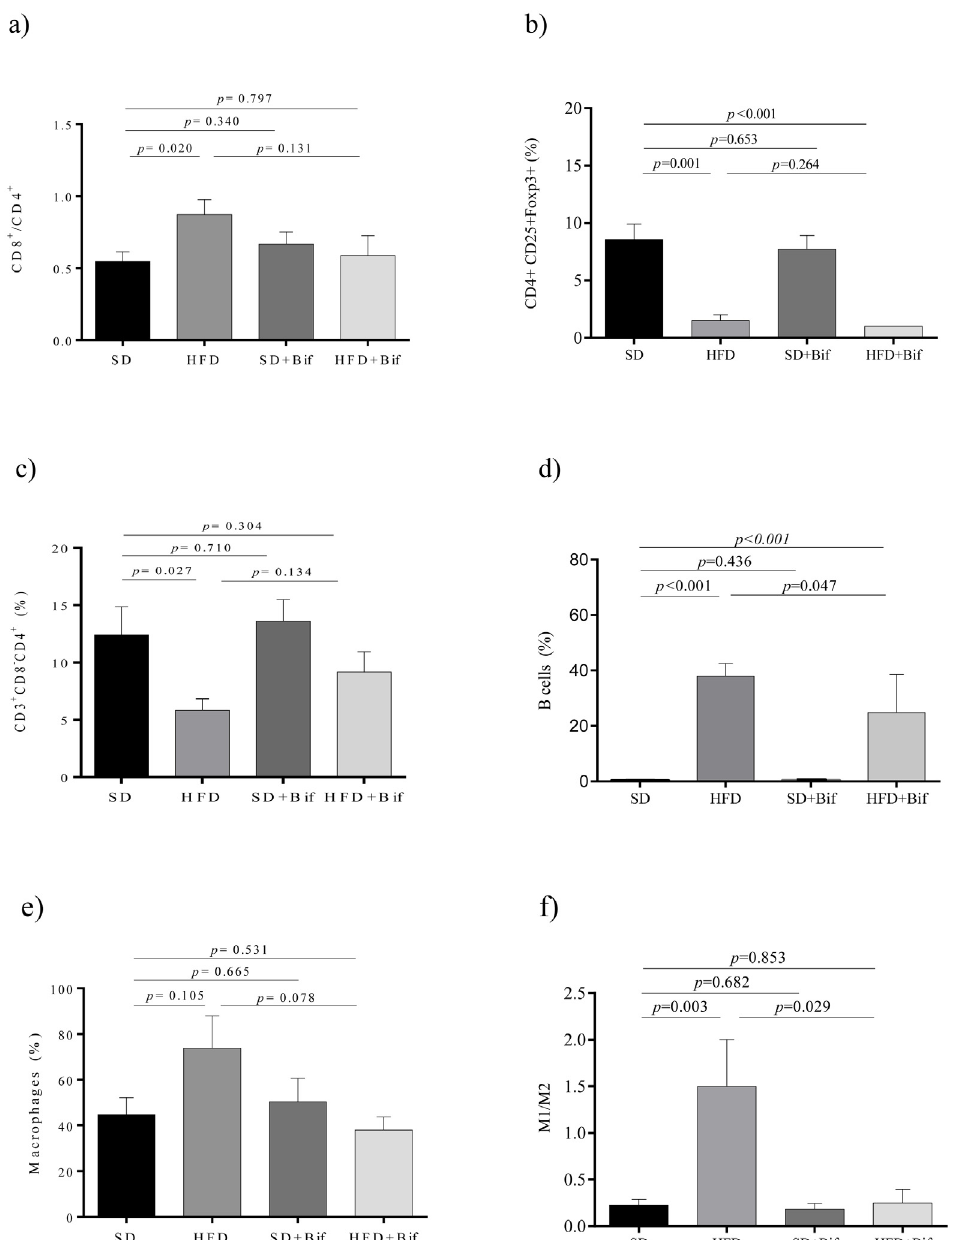
Fig 2. Lymphocyte and macrophage infiltration into epididymal adipose tissue of different mouse groups after 14 weeks of dietary intervention. SD group: control mice receiving a standard diet (SD) plus placebo; HFD group: obese mice receiving a high-fat diet (HFD) plus placebo; SD+Bif group: control mice receiving SD and a daily dose of 1 x 10 9 CFU B . pseudocatenulatum CECT 7765; HFD+Bif group: obese mice receiving HFD and a daily dose of 1 x 10 9 CFU B . pseudocatenulatum CECT 7765 by gavage during 14 weeks (n = 10). The ratio of CD8 + /CD4 + of total CD3+ ( a ), T regulatory (CD4+CD25 +Foxp3+) ( b ), T helper (CD3+CD4+CD8-) ( c ) and B lymphocytes (CD19 + ) ( d ) as well as total macrophages (F4/80+) ( e ) and their subtypes M1 (F4/80 +CD11c+CD206-) and M2 (F4/80+CD11c-CD206+) ( f ) were analysed in each mouse group (n = 10 per group) by flow cytometry. Data are expressed as means and standard error (error bars) and statistically significant differences were determined by ANOVA with Bonferroni ’ s post hoc test a p < 0.050.